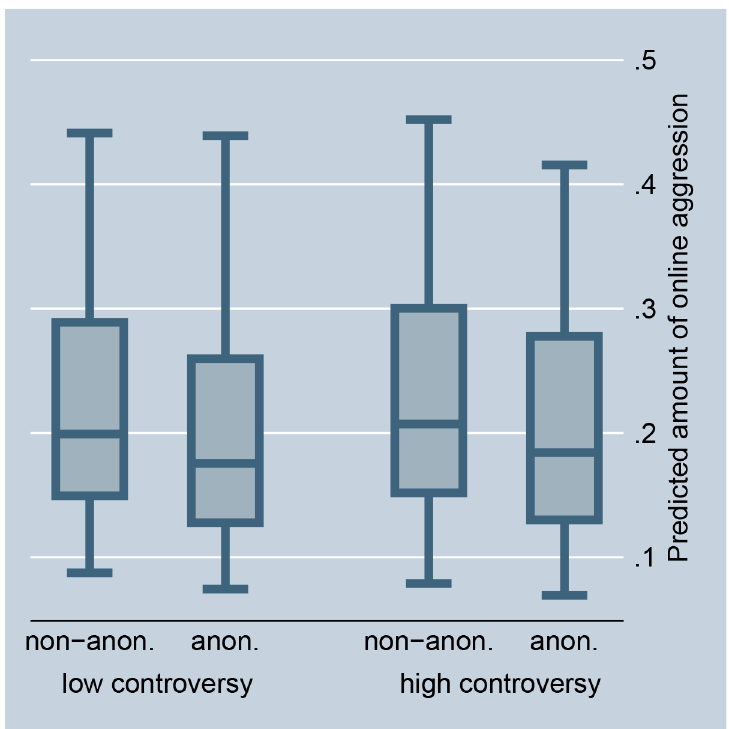
Fig 8. Online aggression dependent on controversy and anonymity (fixed-effects). Predictions of Table 2, Model